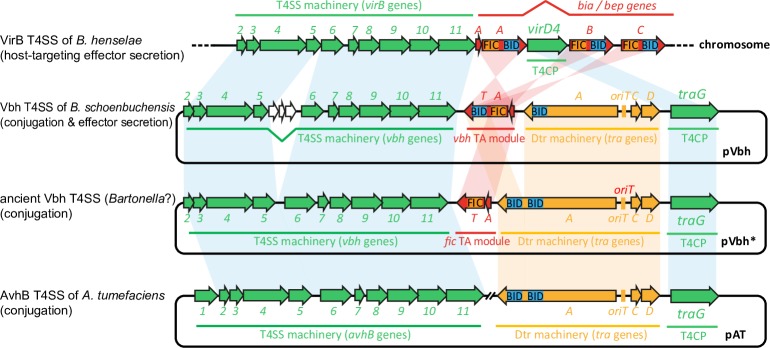
Working model: A VbhT-like interbacterial effector as a missing link in the evolution of Beps from FicT toxins.The model illustrates the homology of genes associated with different T4SS machineries ranging from a regular conjugation system (represented by the AvhB T4SS of A. tumefaciens, bottom) to a host-targeting, effector secreting virulence factor (VirB T4SS of B. henselae, top). Core components of the T4SS machinery and the T4CP are shown in green, the Dtr machinery is shown in yellow, and TA modules or effectors are shown in red. Note that the VbhTA module of B. schoenbuchensis pVbh (second from top) displays the same domain architecture as the majority of extant Beps and likely their common ancestor. Like VbhT, the most upstream Bep (BepA) is encoded with a FicA antitoxin that is called BiaA in the context host-targeted Bartonella effectors [11]. Based on the genomic islands with Vbh-like T4SS and FicTA modules like BtrFicTA (Fig 4), we infer an ancient pVbh-like plasmid in which a FicTA module was encoded between the conjugative relaxase and the T4SS machinery (second from bottom). It is clearly apparent that a DNA rearrangement fusing one BID domain of the relaxase with the FicT toxin–i.e., classical terminal reassortment–would create a VbhT-like interbacterial effector as evidenced by the clear composite architecture of this protein (Fig 6). We therefore speculate based on these homologies that an evolutionary process from the bottom to the top of this model may approximate the evolutionary history of the host-targeting VirB T4SS.